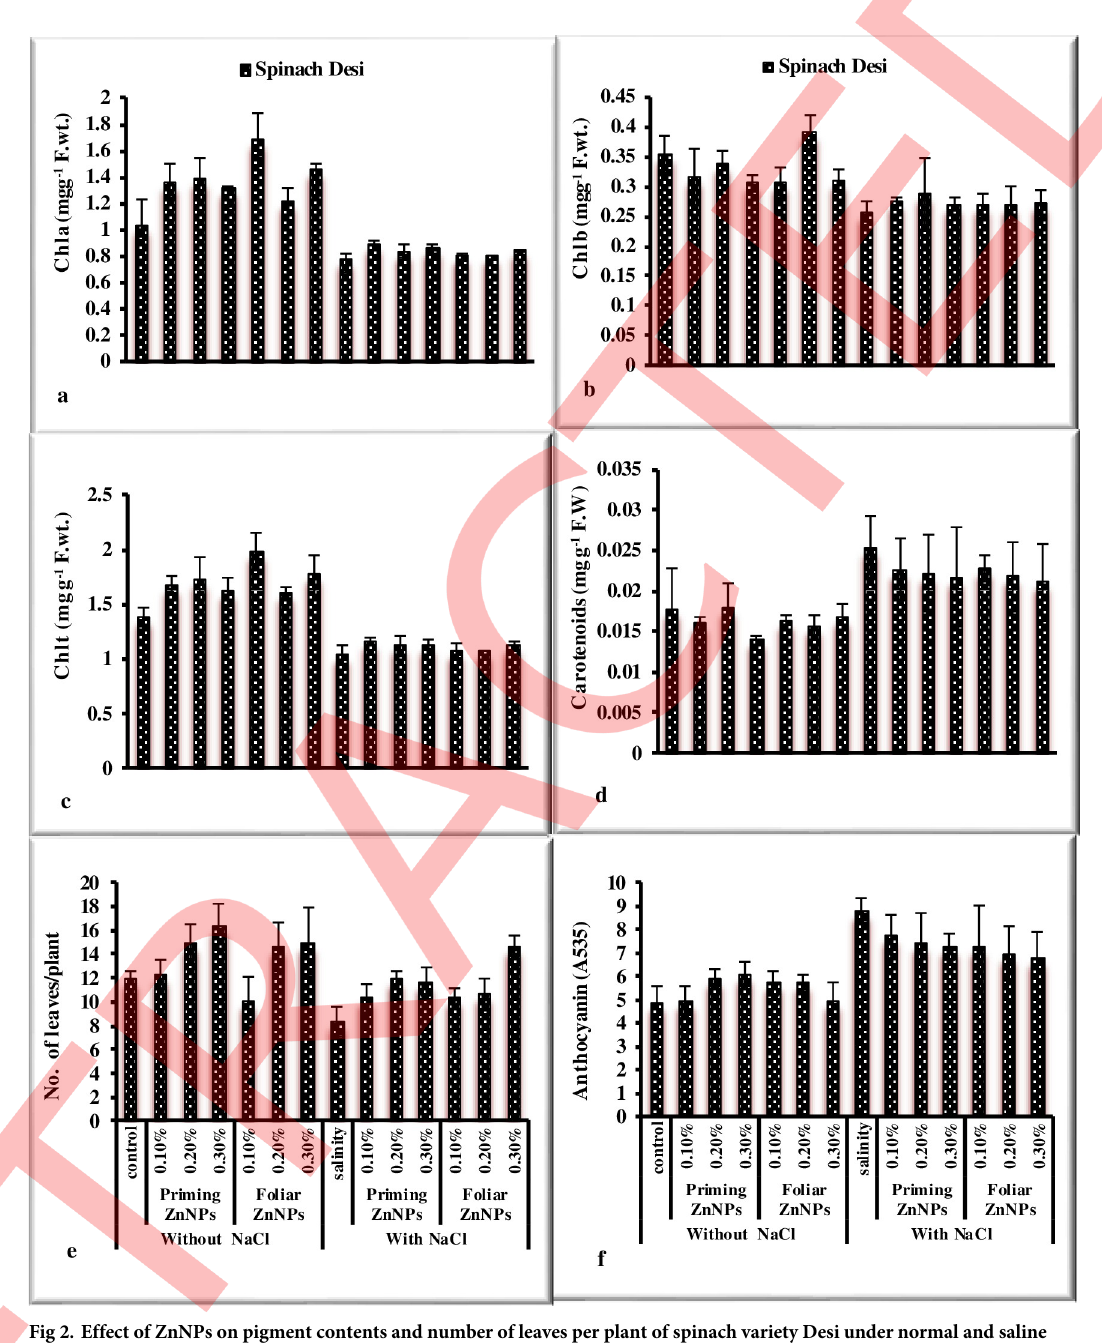
Fig 2. Effect of ZnNPs on pigment contents and number of leaves per plant of spinach variety Desi under normal and saline conditions.